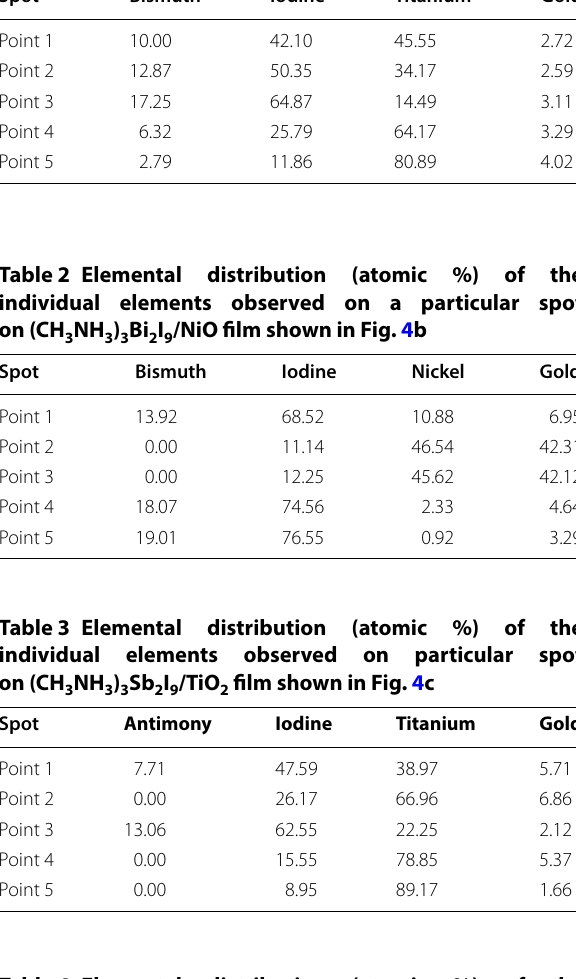
Table 5 Elemental distribution (atomic %) of the individ- shown in Fig. 4e Gold